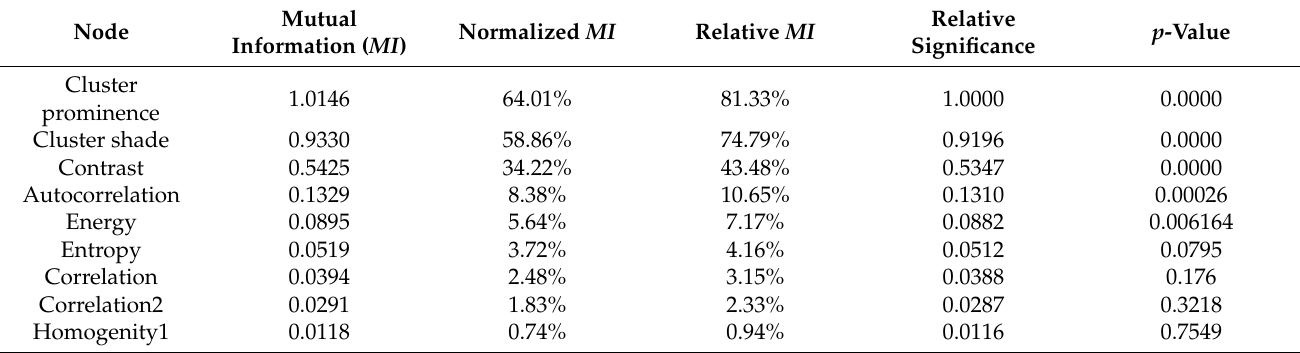
Table 2. Overall analysis of the highly ranked feature “dissimilarity” (target feature) with other extracted features.